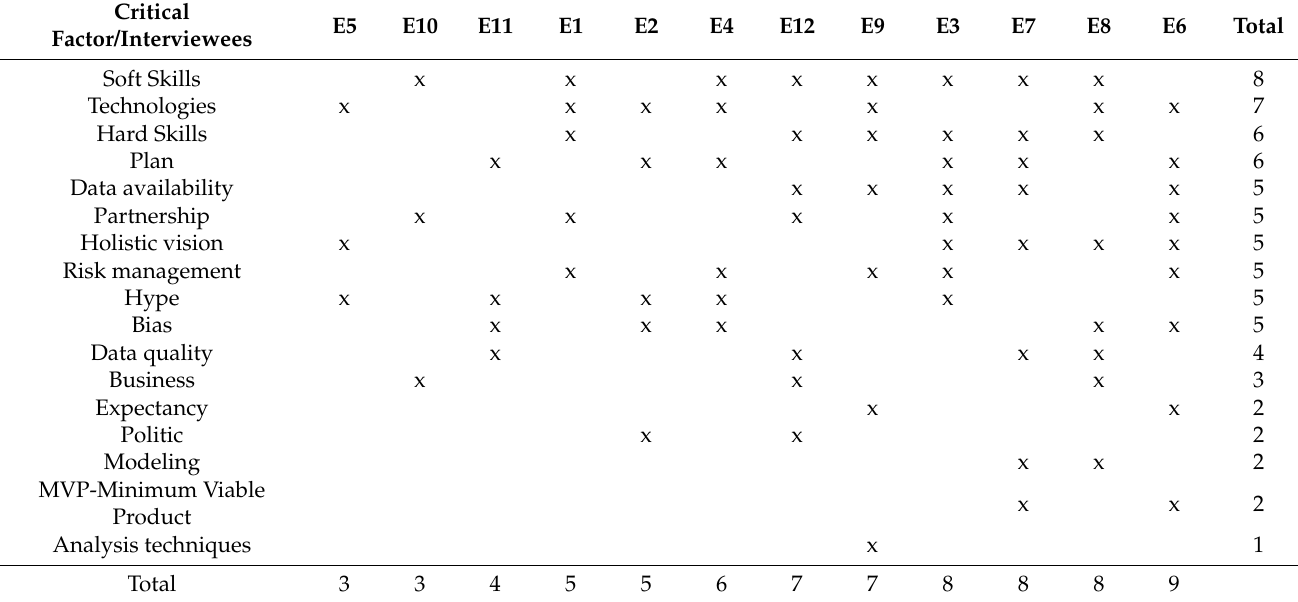
Table 4. Critical factors in Big Data